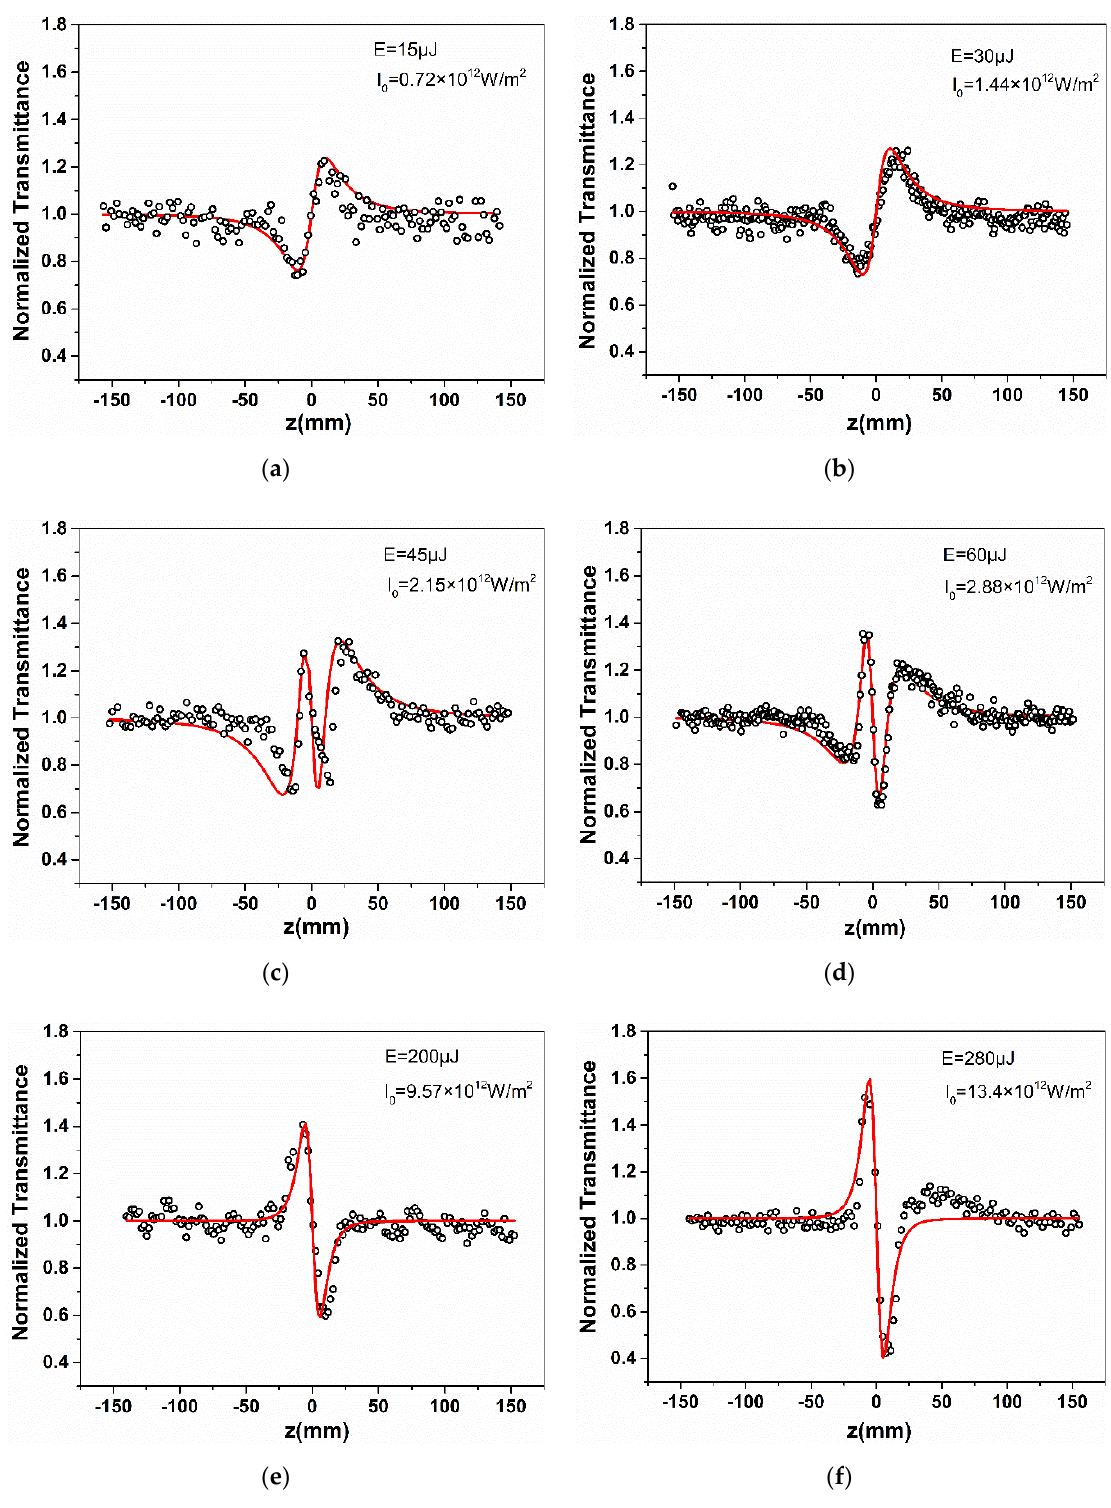
Figure 4. CA Z-scan curves of AgNPs under different laser energy. ( a ) laser energy of 15 µ J (irradiance at focus of 0.72 × 10 12 W/m 2 ); ( b ) laser energy of 30 µ J (irradiance at focus of 1.44 × 10 12 W/m 2 ), ( c ) laser energy of 45 µ J (irradiance at focus of 2.15 × 10 12 W/m 2 ); ( d ) laser energy of 60 µ J (irradiance at focus of 2.87 × 10 12 W/m 2 ); ( e ) laser energy of 200 µ J (irradiance at focus of 9.57 × 10 12 W/m 2 ); ( f ) laser energy of 280 µ J (irradiance at focus of 13.4 × 10 12 W/m 2 ). The small circles and the red solid curves are experimental data and theoretical fitting, respectively.